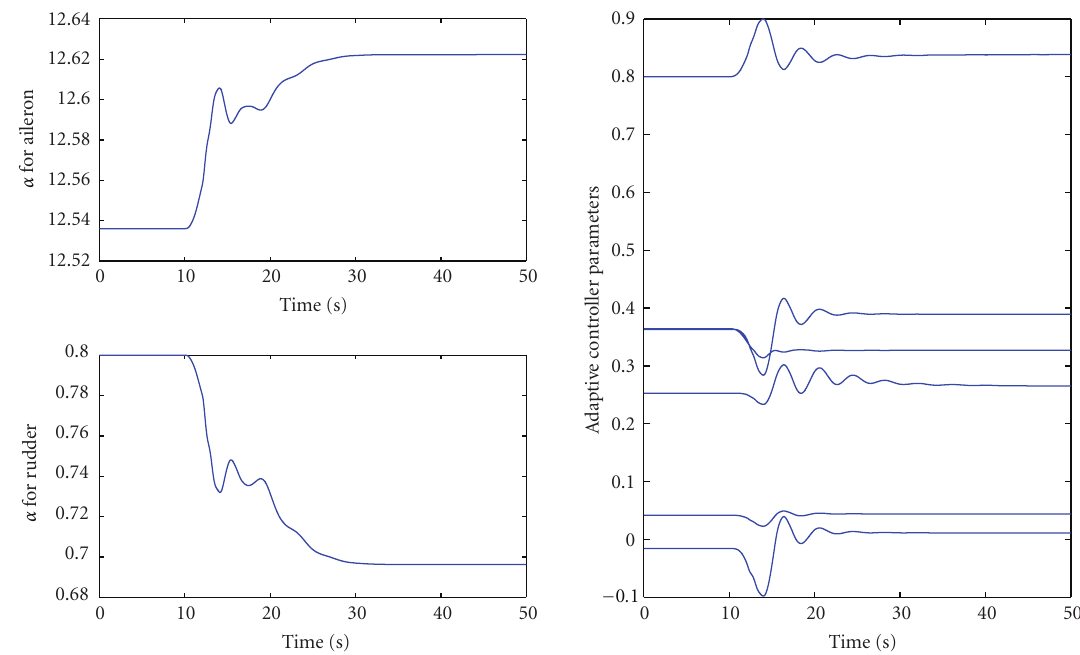
Figure 14: Time history of allocation gains and adaptive